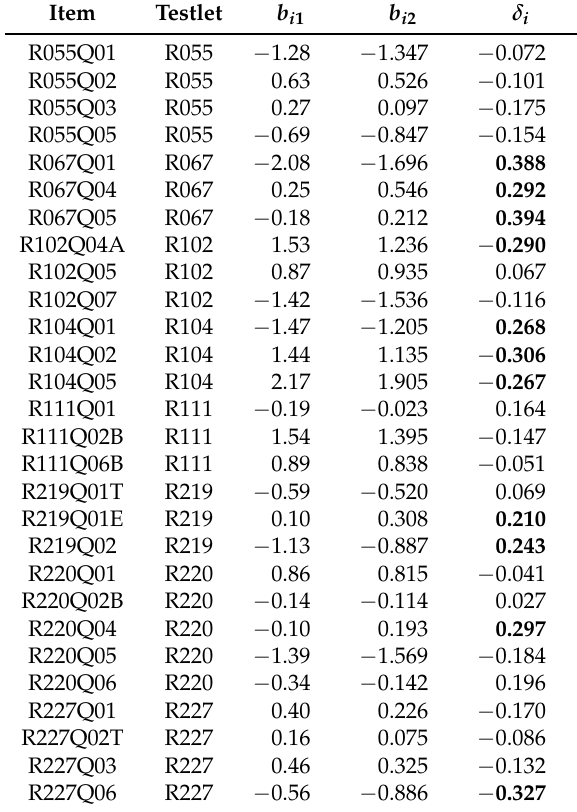
Table A5. 1PL Linking Study: Item Parameters Taken from Monseur and Berezner [125]. Item Testlet b i 1 b i